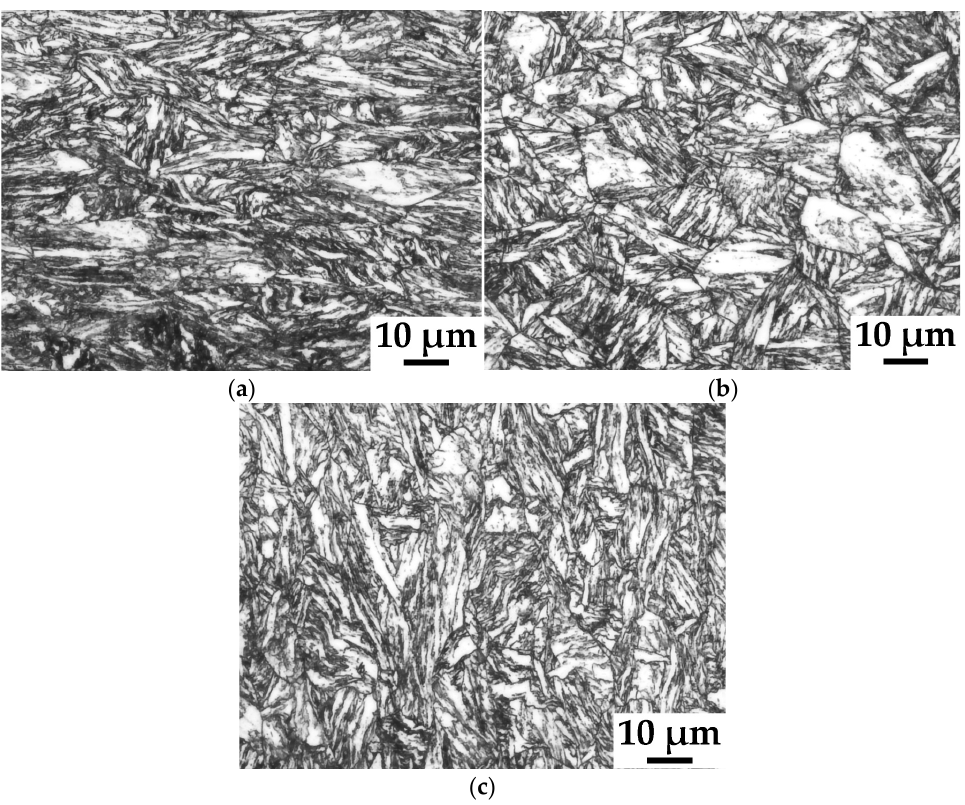
Figure 4. The OM images of the 5% Ni steel at the bending axis: ( a ) near the outer arc surface, ( b ) transition region near the mid-thickness, and ( c ) near the inner arc.